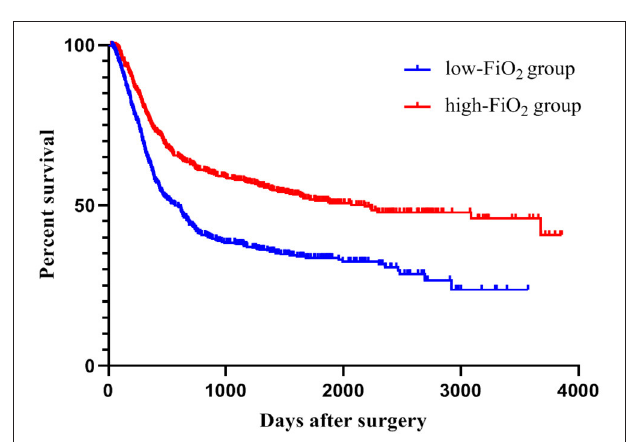
FIGURE 4 | FiO 2 and recurrence-free survival. Patients were divided into low-FiO 2 group and high-FiO 2 group. The p-value was evaluated using the log-rank test ( p < 0.001). FiO 2 , Fraction of inspired oxygen.